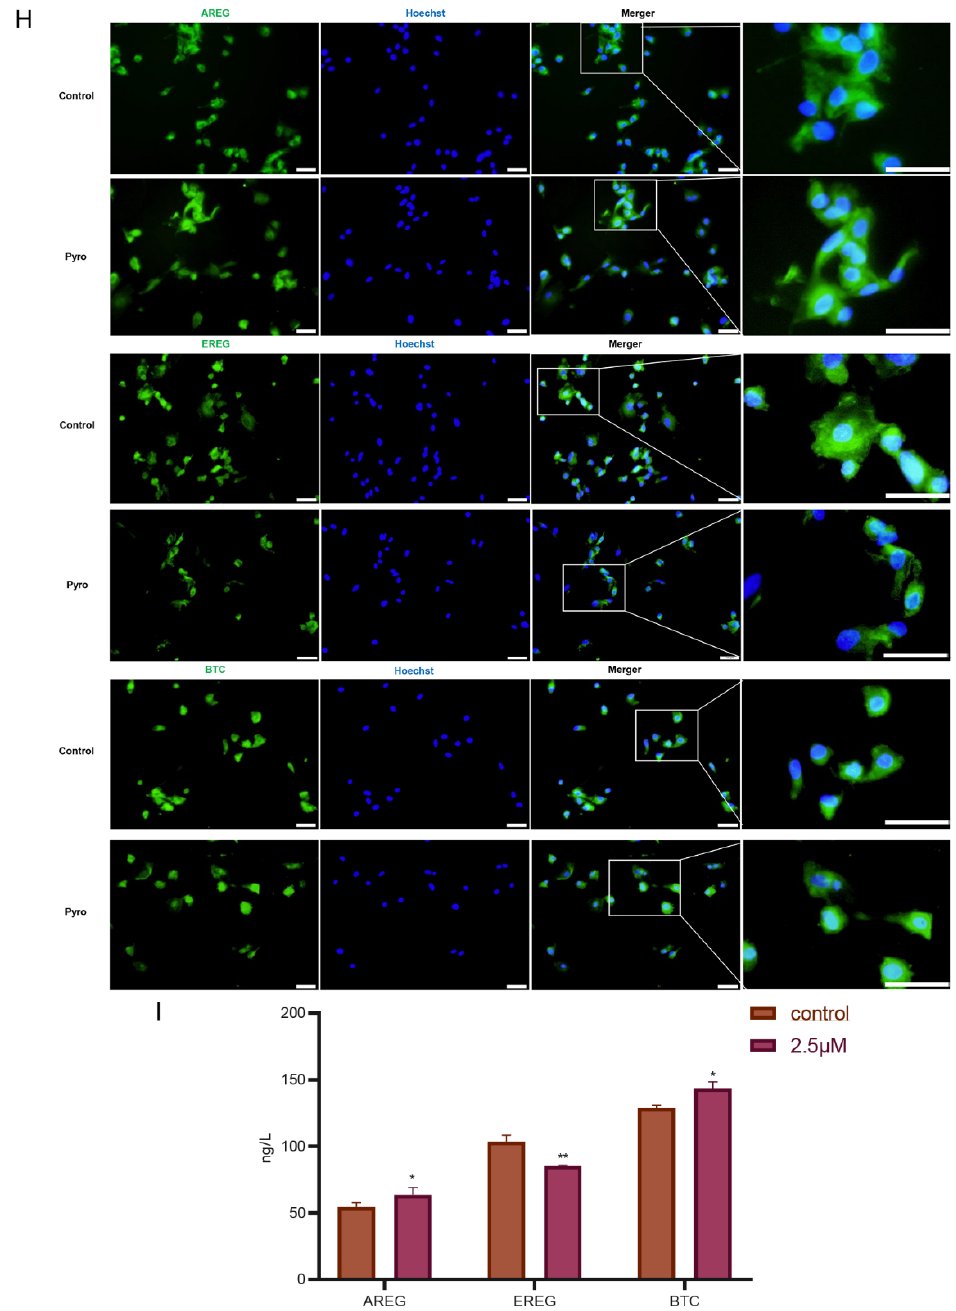
Figure 3. The effect of HDAC1 inhibition on the expression and secretion of EGF-like growth factors in cultured granulosa cells from Tan sheep. ( A , B ): Analysis of the effect of the LH time on HDAC1 protein expression. ( C–E ): Screening the inhibitory efficiency of pyroxamide, a specific inhibitor of HDAC1, regarding the levels of proteins, as indicated by acetylated lysin. ( F , G ): The expression levels of the EGF-like growth factors in response to pyroxamide treatment. ( H ): The expression levels of the respective EGF-like growth factors detected by immunofluorescence. The green fluorescence indicated AREG, EREG and BTC, and the blue fluorescence indicated Hoechst staining to mark the nucleus. The scale was 100 μ m; the rightmost column contains an enlarged view of the merged figure. ( I ): The respective levels of the secreted AREG, EREG and BTC in the cultured granulosa cells of the Tan sheep. * p < 0.05; ** p < 0.01; *** p < 0.001; ns: Indicate no significant differences, n = 3.